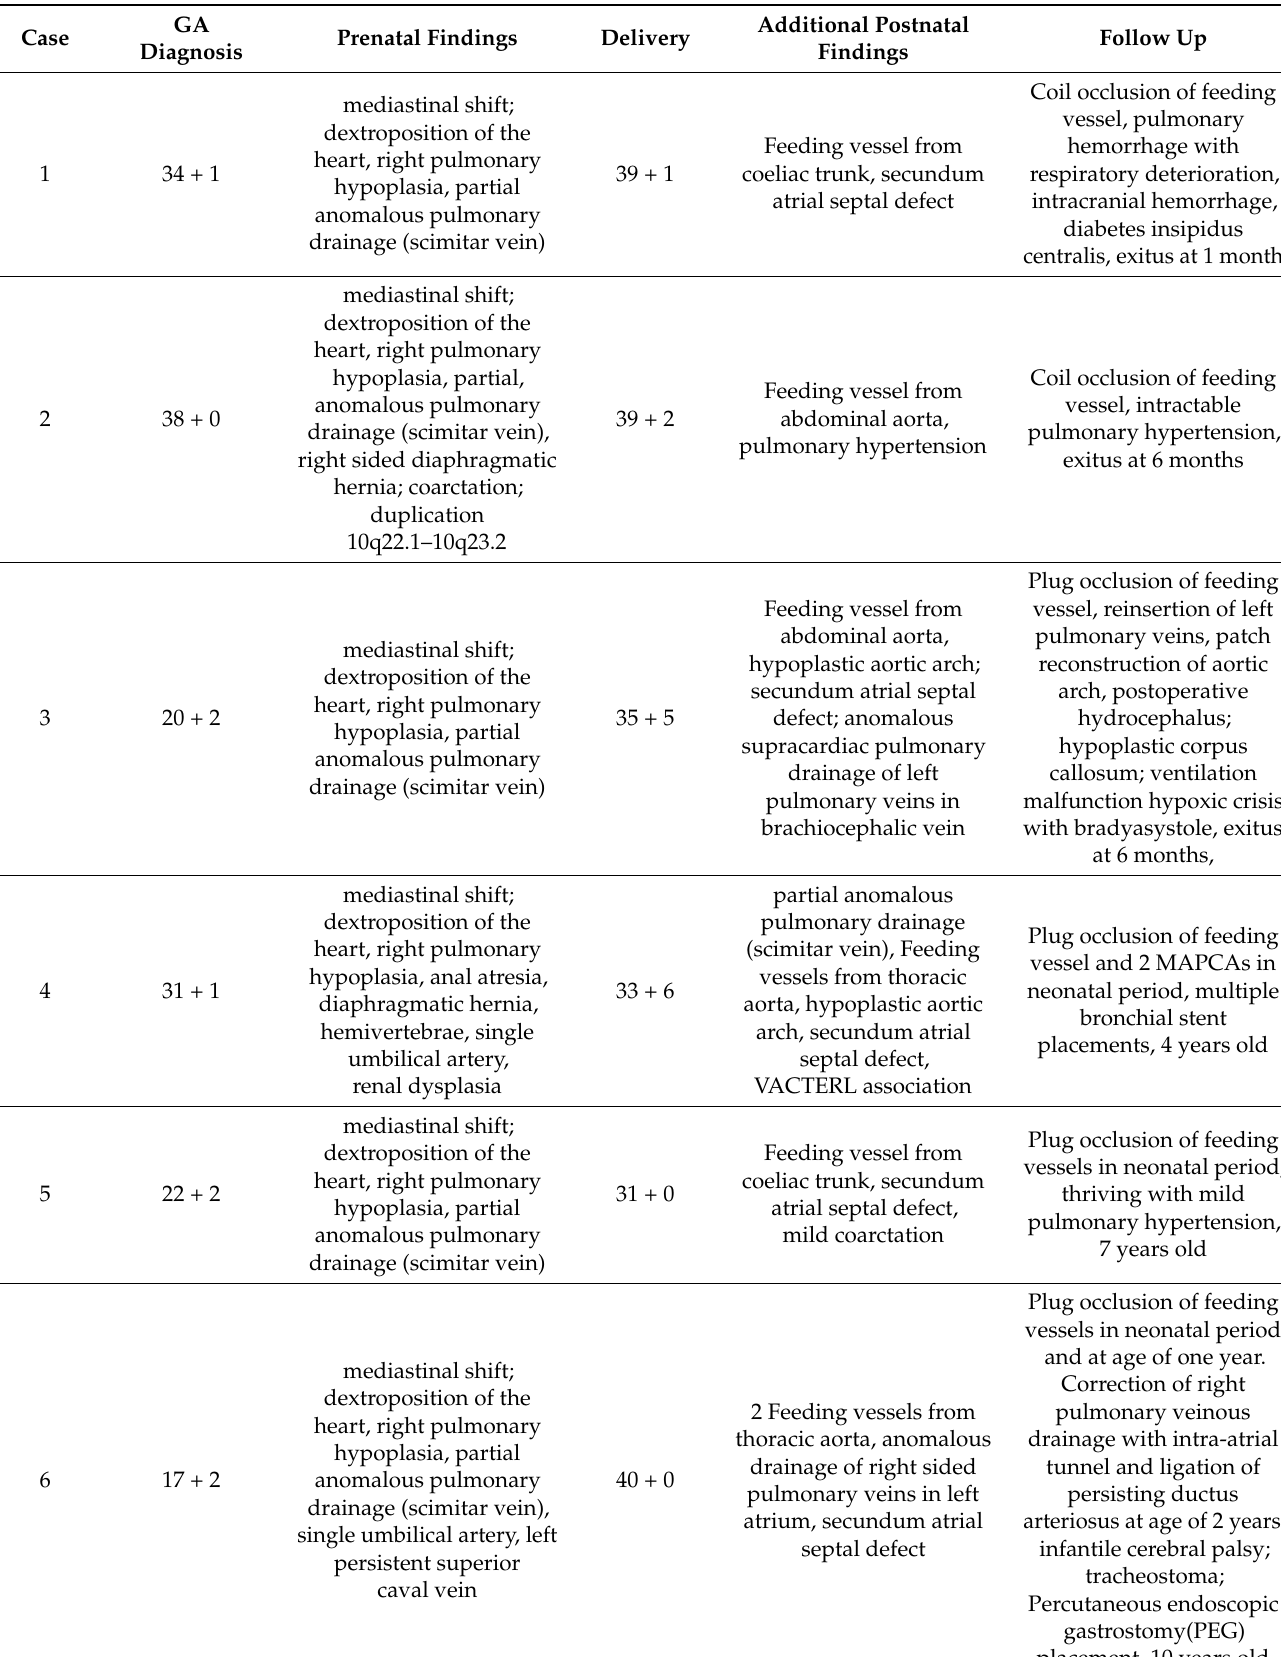
Table 1. Presentation of the prenatal and postnatal characteristics of fetuses with scimitar